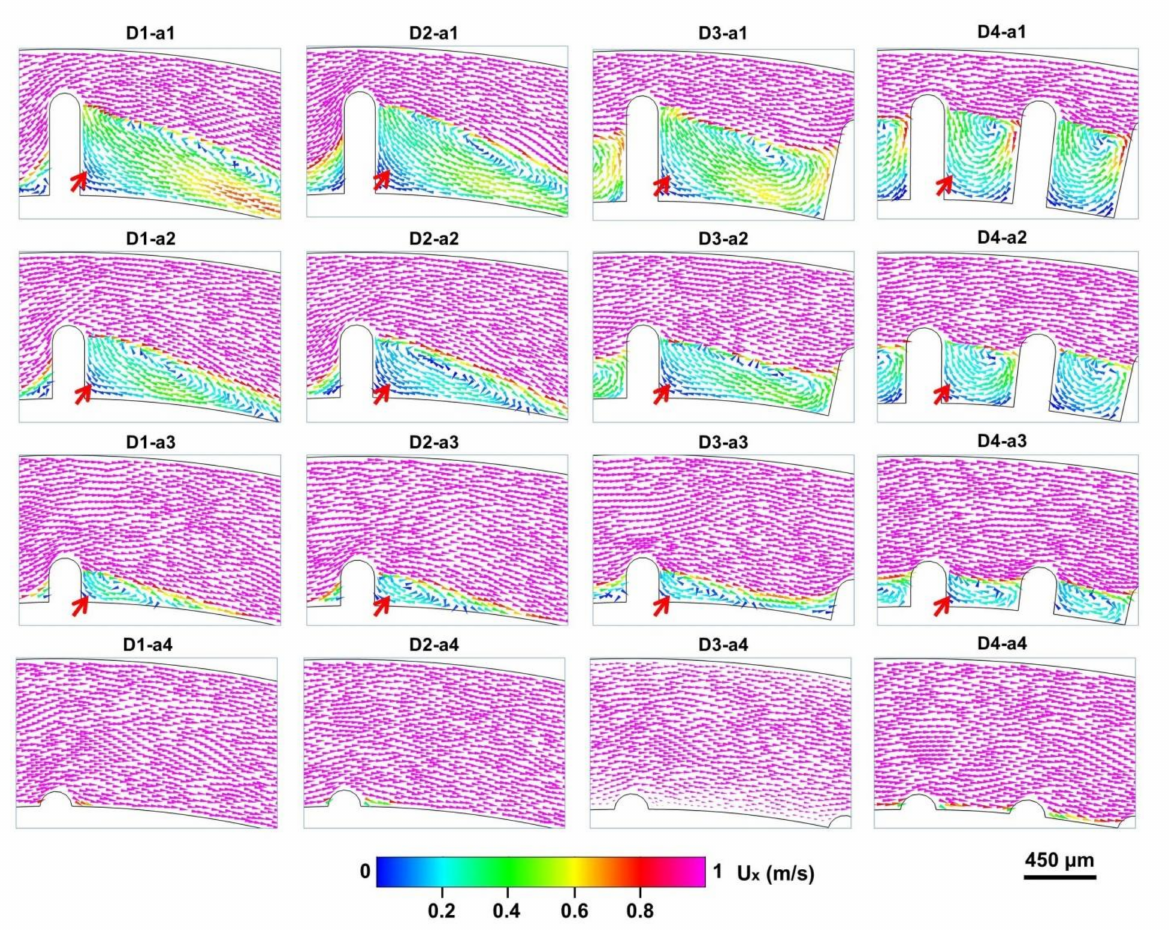
Figure 5. Simulated fluid velocity field of the helical vortex induced by micro-obstacles by arrow distribution in the x-axis of the D-channels (D1, D2, D3, D4) at a flow rate of 15 mL min − 1 . a1, a2, a3, and a4 represent 270, 450, 630, and 810 µ m width of the narrow regions in Figure 1A respectively. The red arrows represent different vortex formations in the